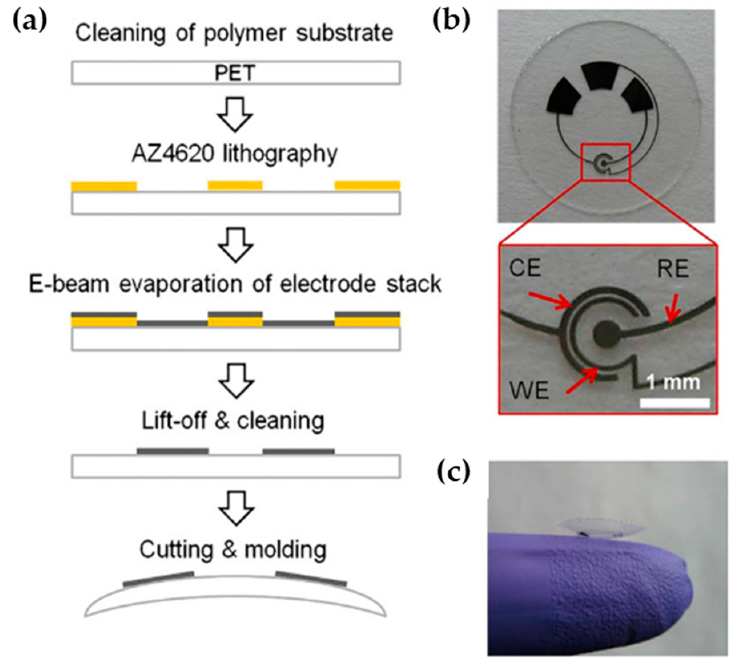
Figure 21. ( a ) Photograph of the mouthguard biosensor integrated with wireless amperometric circuit board; (b) reagent layer of the chemically modified printed Prussian blue carbon working electrode containing uricase for salivary uric acid (SUA) biosensor; (c) photograph of the wireless amperometric circuit board: front side (left) and back side (right). Reprinted with permission from reference [148]. Copyright © 2015 Elsevier B.V.